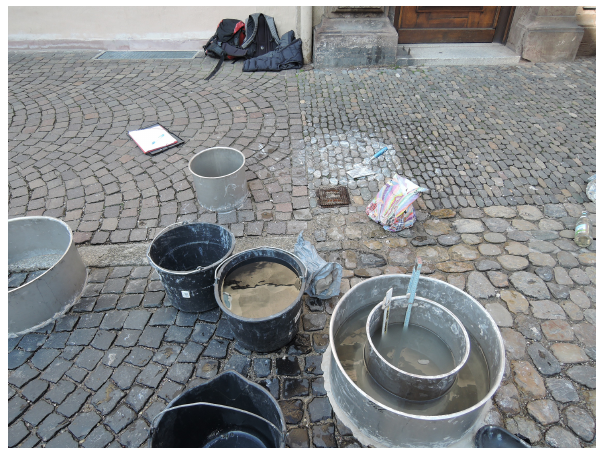
Figure 5. Infiltration experiments at the plots of cluster